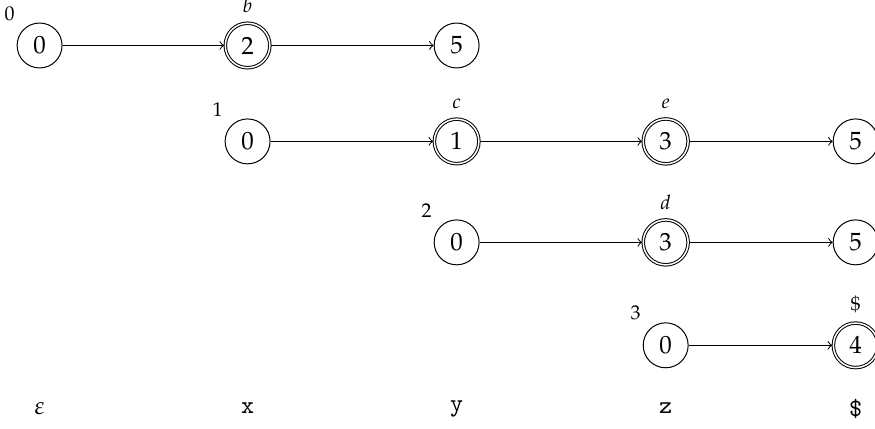
Figure 13. The scanner trace outlining the paths taken through the scanner automaton using the spec- ification Ξ in